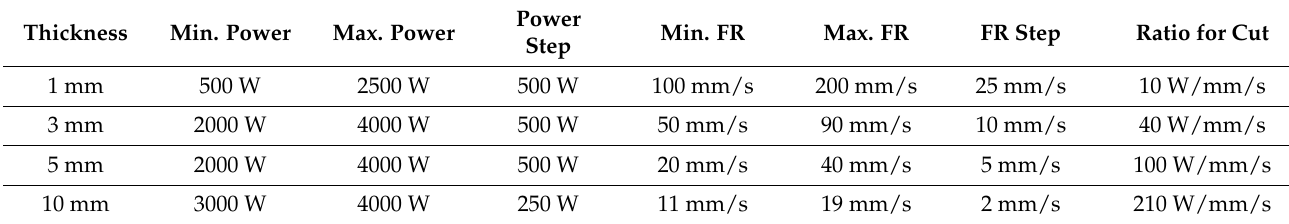
Table 1. Parameter spaces for laser cutting. FR: feed rate.